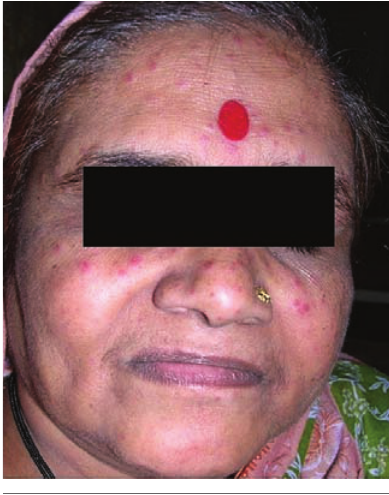
Figure 6. Typical lesions of eruptive pseudoangioma in an adult Indian patient.